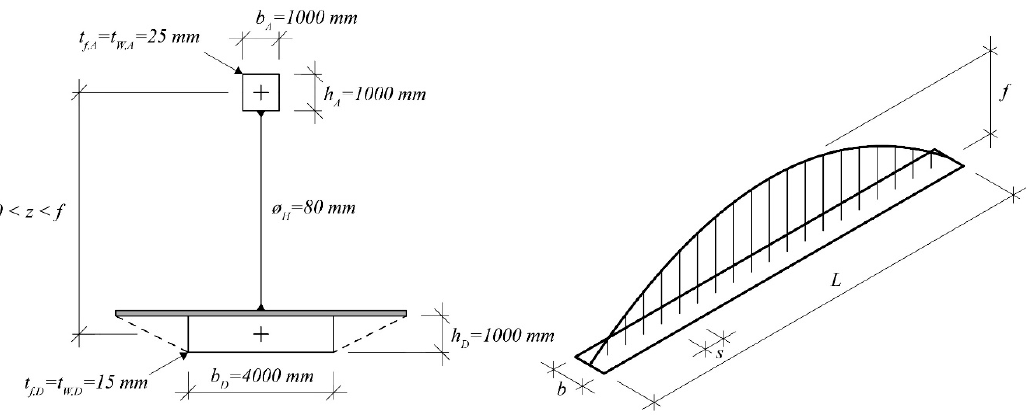
Figure 3. Geometrical definition of the reference arch bridge (see Table 1).